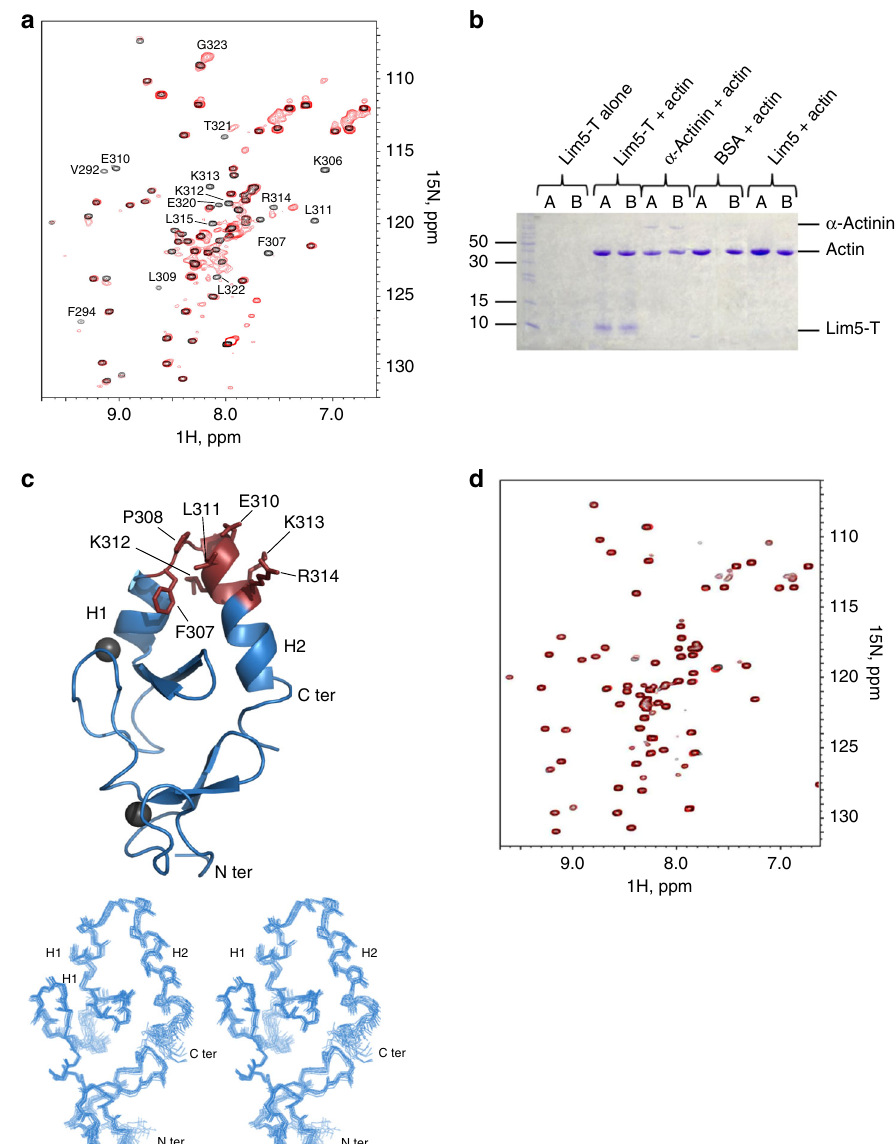
Fig. 2 Mapping and structural analysis of the major actin binding site in PINCH-1. a Overall, 0.1 mM 1 H- 15 N HSQC of LIM5-T in the absence (black) and presence (red) of 0.2 mM AP-actin showing that LIM5-T binds to G-actin. Strongly perturbed residues in LIM5-T by the actin binding are labeled, which primarily involve PINCH-1 C-terminal tail. b Co-sedimentation data (pellets in duplicates) showing LIM5-T but not LIM5 alone binds to F-actin. c (Top) NMR structure of LIM5-T and the actin binding surface derived from the chemical shift mapping. Note that the H2 helix that packs against the LIM domain as re fl ected in all calculated structures. Residues undergoing the largest chemical shift changes upon interaction with AP-actin are shown with side chains. Two zinc atoms are shown as gray spheres. (Bottom) Superposition of 20 lowest energy structures of LIM5-T. d 0.1 mM 1 H- 15 N HSQC of C-terminal LIM5- T 4A mutant (F307A/L311A/K312A/K313A) in the absence (black) and presence (red) of 0.2 mM AP-actin showing that the mutations drastically